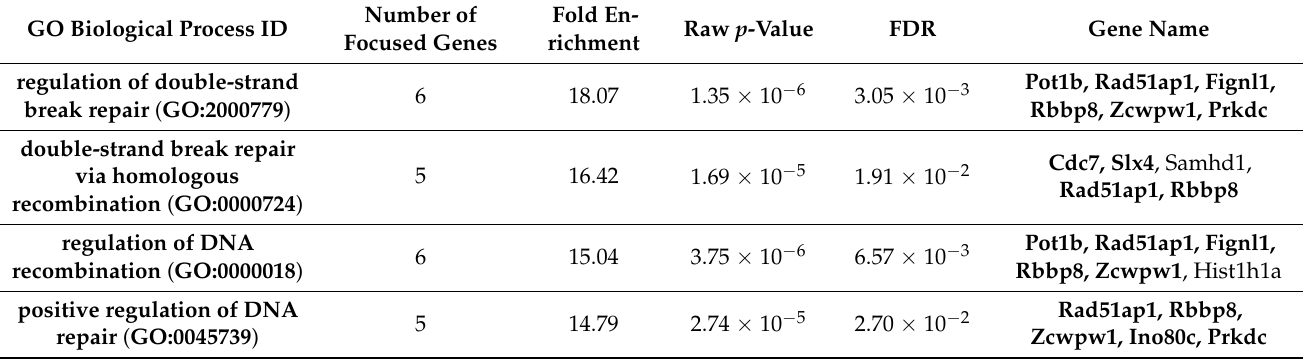
Table 3. Top four GO terms from analysis of the 86 most sensitive genes in Nrf1 f/f ; Rho iCre